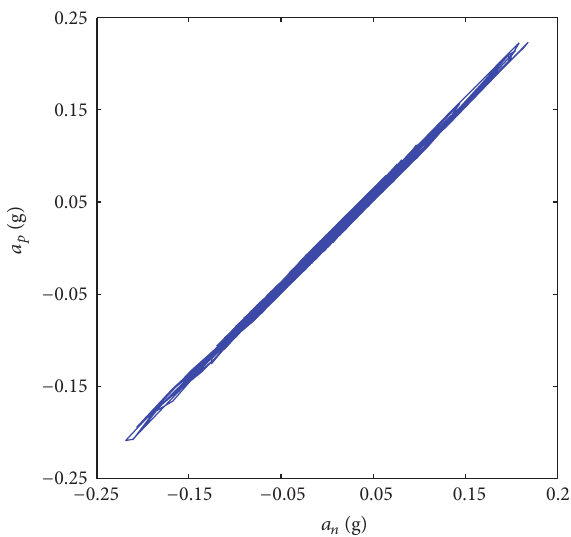
Figure 13: Control performance of the table below